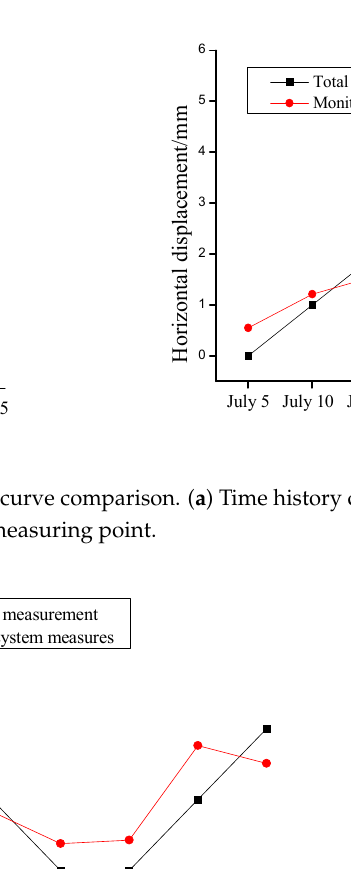
history curve of No. 2 measuring point.